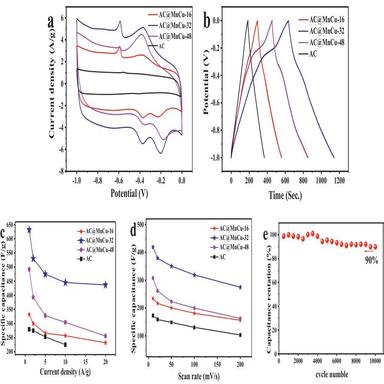
Comparison of (a) CV curves at a scan rate of 5 mV/s and (b) GCD curves at a current density of 1 A/g of the four electrode materials in the three-electrode system; (c) the specific capacitance of four electrode materials varies with the current density; (d) the specific capacitance of four electrode materials varies with the scan rate. (e) Cycle stability of AC@MnCu-32.